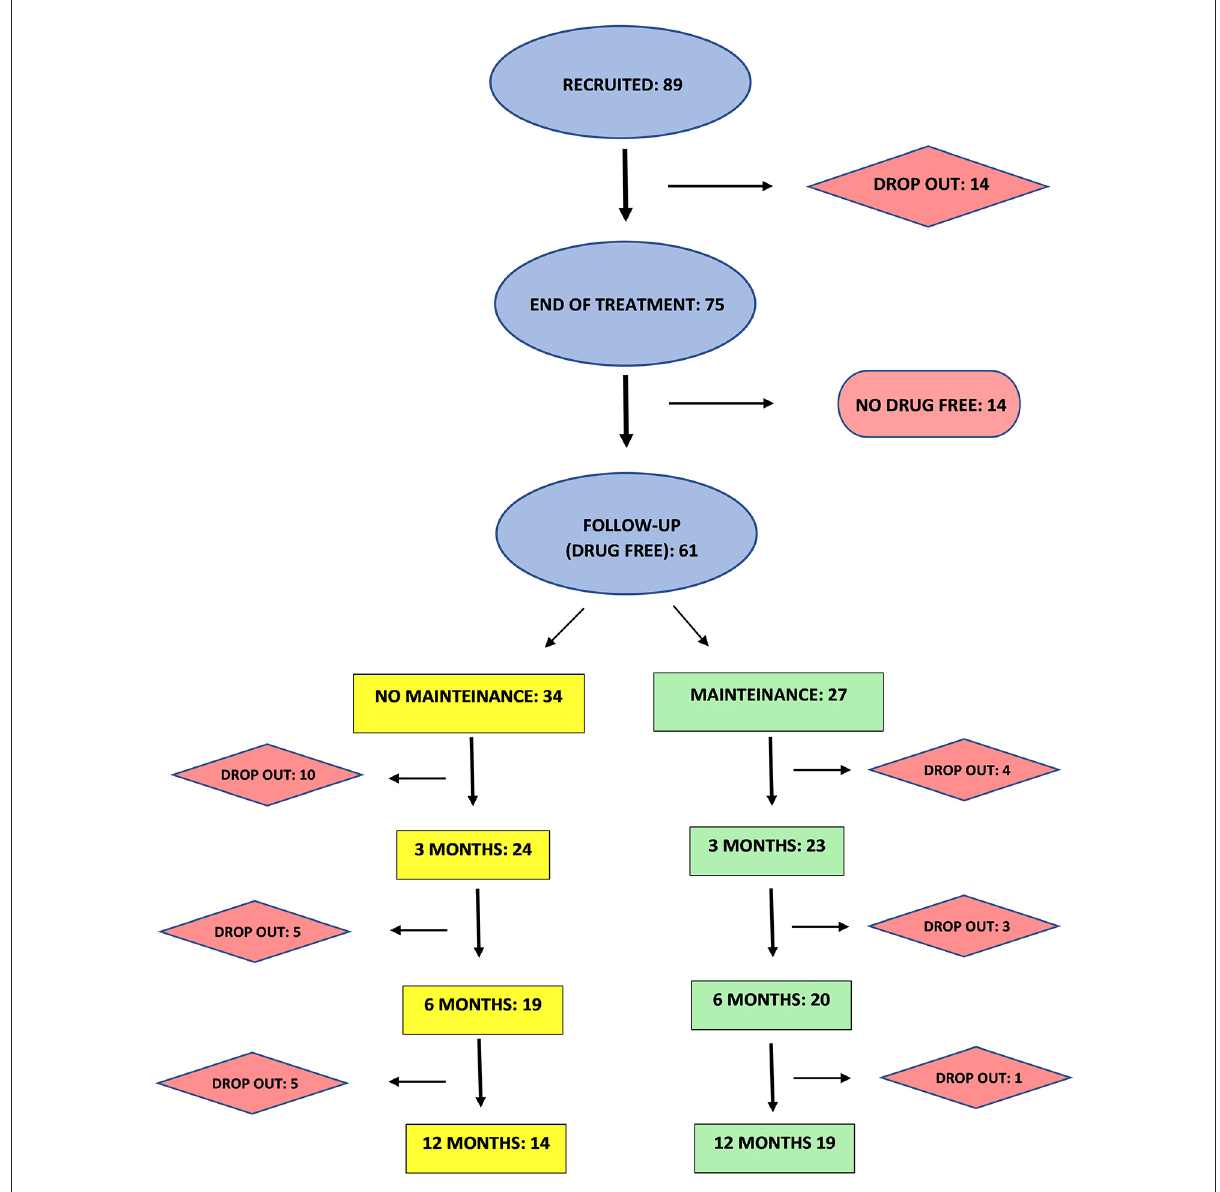
FIGURE1 Experimental procedure flow-chart.